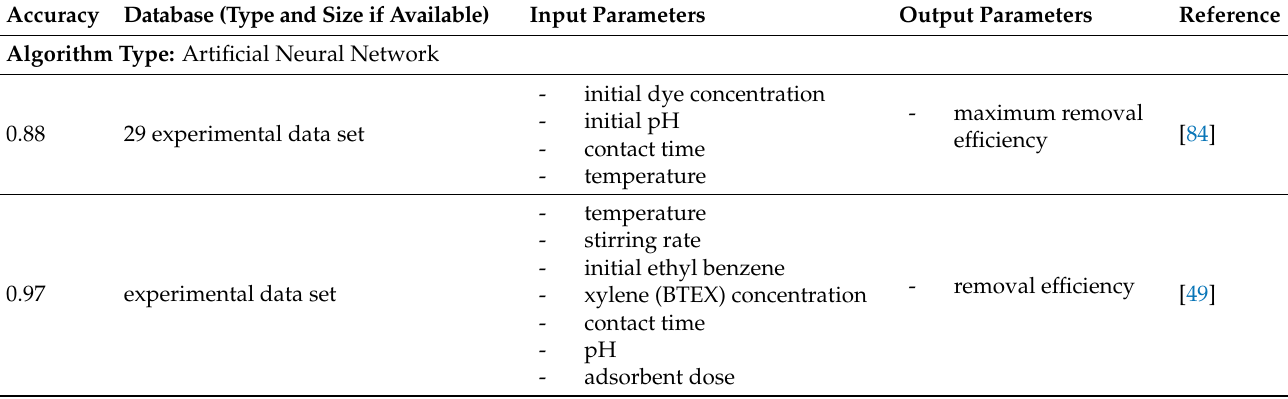
Table 7. The comparison of the algorithms for prediction of the removal